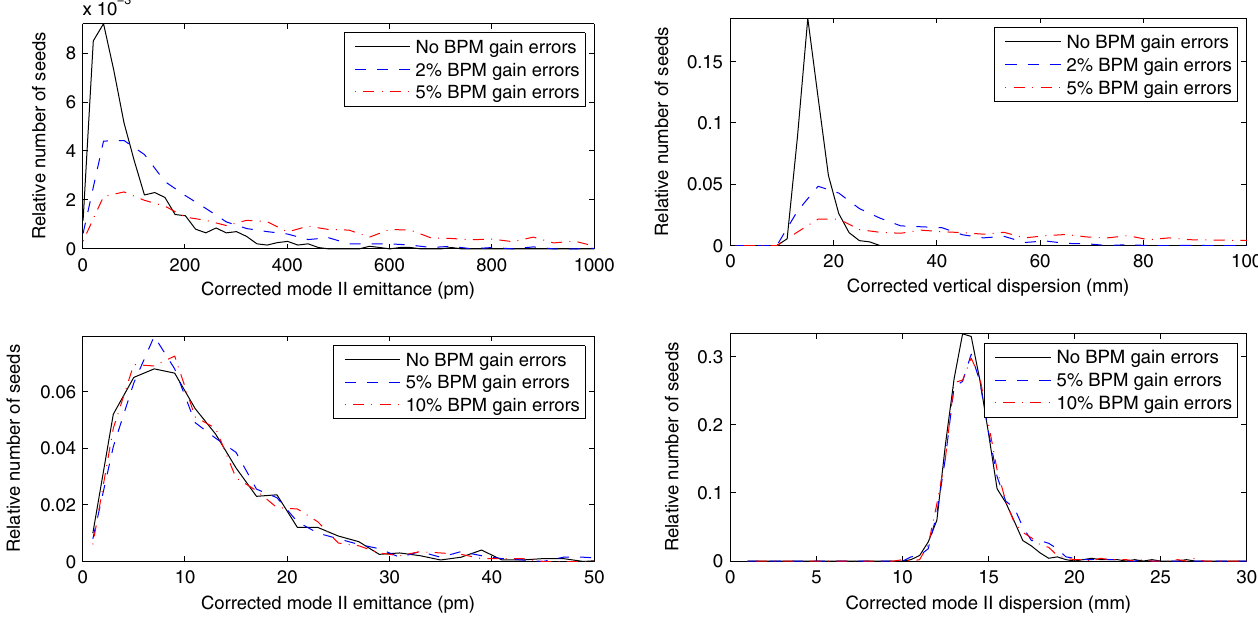
FIG. 6. Distribution (from 1000 seeds of machine errors with rms shown in Table I) of final mode II emittance (top and bottom, left) and dispersion (top and bottom, right) after correction of dispersion measured at the BPMs. The vertical axes are scaled so that each curve has unit area. Top: emittance (left) and vertical dispersion (right) after tuning based on correction of vertical ( y ) dispersion. Bottom: emittance (left) and mode II dispersion (right) after tuning based on correction of mode II dispersion. In each case, the dispersion is the rms of the dispersion measured at the BPMs (including measurement errors, corresponding to a resolution of 12 mm). Note the different horizontal scales between the top plots and the bottom plots. Note also that the emittance distribution for the correction based on vertical dispersion is sensitive to the magnitude of the BPM gain errors, whereas the emittance distribution for a correction based on mode II dispersion is insensitive to the BPM gain errors. Black lines correspond to no BPM gain errors; blue lines correspond to 2% (vertical dispersion correction) or 5% (normal mode dispersion correction) gain errors; and red lines correspond to 5% (vertical dispersion correction) or 10% (normal mode dispersion correction) gain